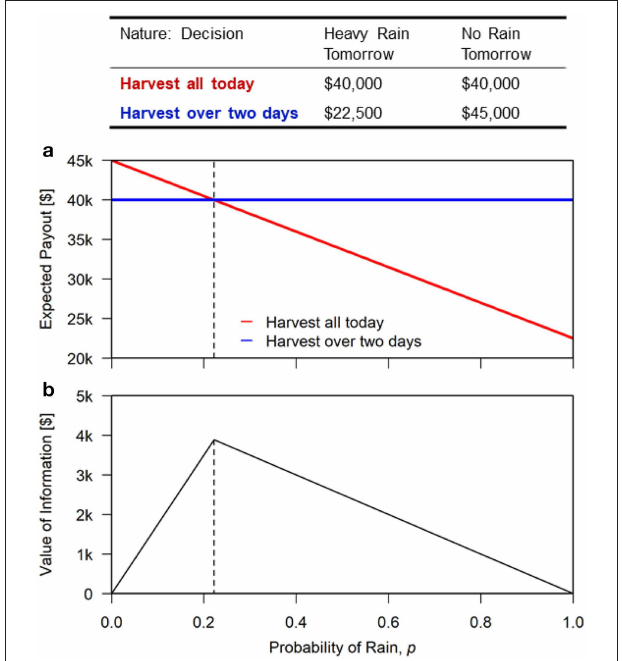
FIGURE 2 | Illustration of Value of Information based on the decision whether or not to harvest crops. Table shows the expected payout matrix for the decision of when to harvest. (a) Expected payout based on the subjective probability of heavy rain in the future. (b) Expected Value of Information for improved rain forecast. The dashed vertical line represents the point at which the farmer’s uncertainty is highest, representing the highest value of information. Figure adapted from Macauley